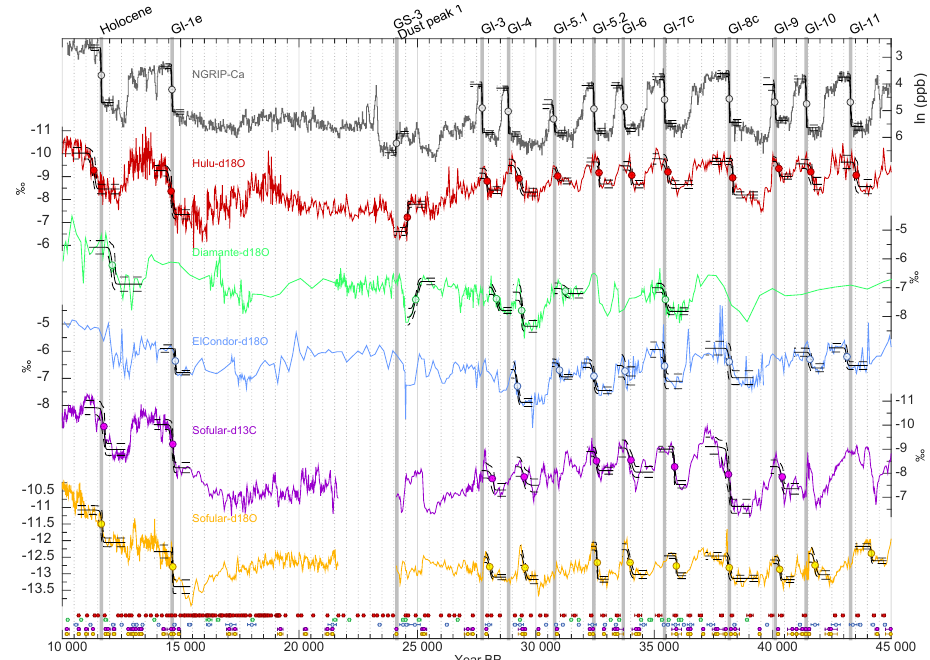
Figure 13. Timing of abrupt climate changes in different climate records. The climate archive and proxy are indicated in each panel. The black lines show the mean of the fitted ramps and their 95% confidence intervals (dashed). The dots mark the midpoint of the mean transition. The U / Th dates and their ± 1 σ uncertainties of each climate record are shown at the bottom of the figure in color coding corresponding to the respective climate record. Each time series is shown on its original timescale not applying any